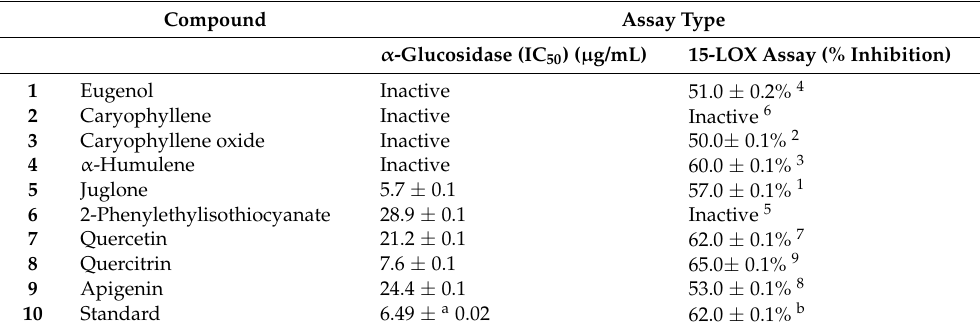
Table 5. α -Glucosidase and 15-LOX inhibitory activity of test